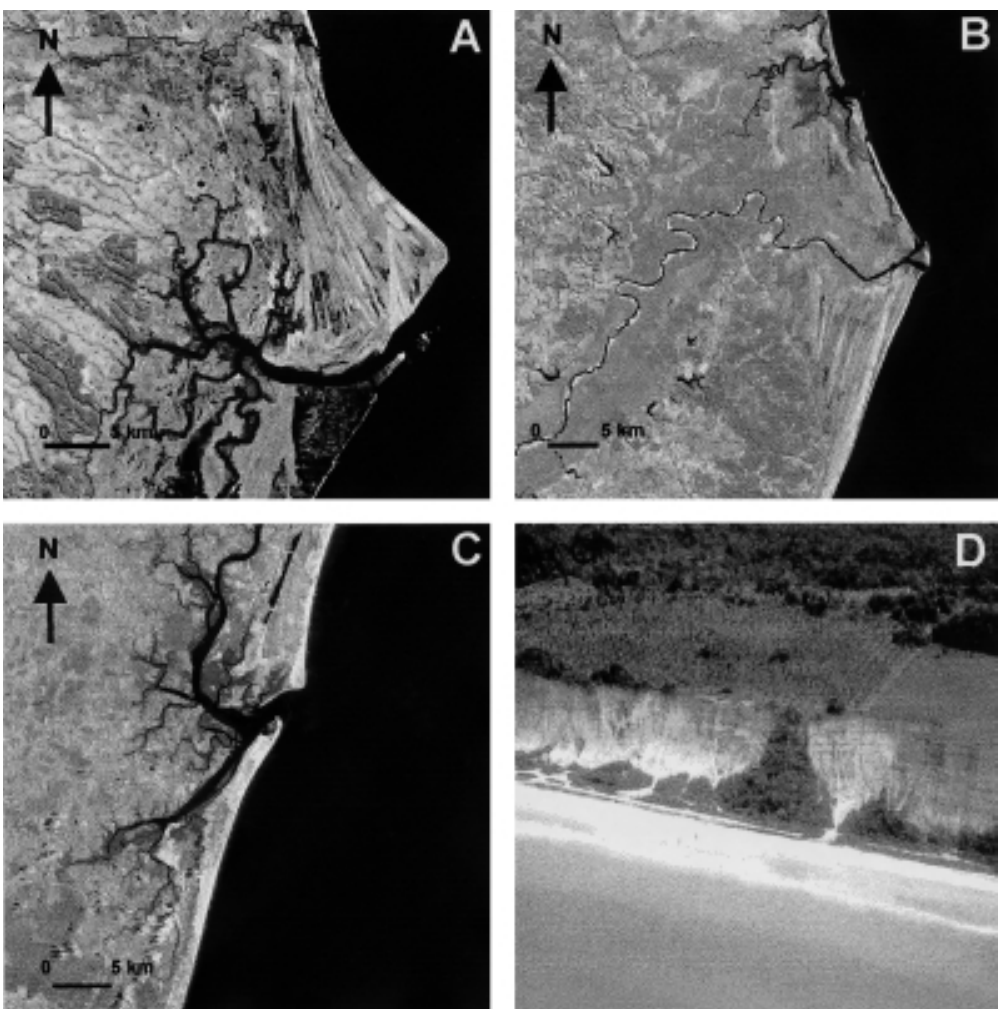
Fig. 8 – (A) Cuspate accumulation form in the region of Caravelas (Also see figure 2). (B) Cuspate accumulation form in the region of Belmonte (Also see figure 2). (C) Mangue Seco spit (Also see figure 6). (D) Active sea cliffs in sediments of Barreiras Formation located on the north of Corumbáu Point (Also see figure